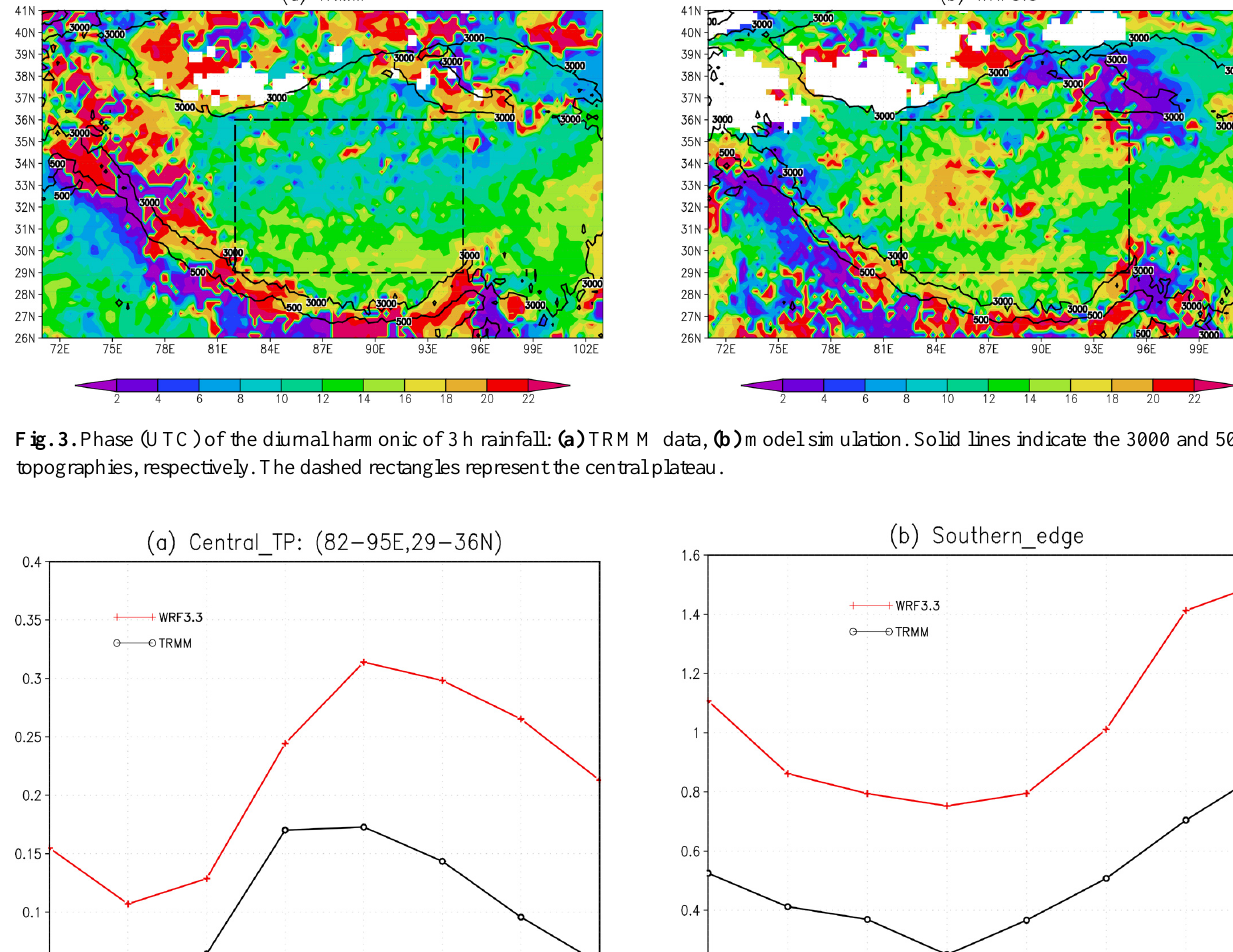
A i and ϕ i are the amplitude and phase of the i -th harmonic mode, respectively. The calculated ϕ 1 is the timing of the